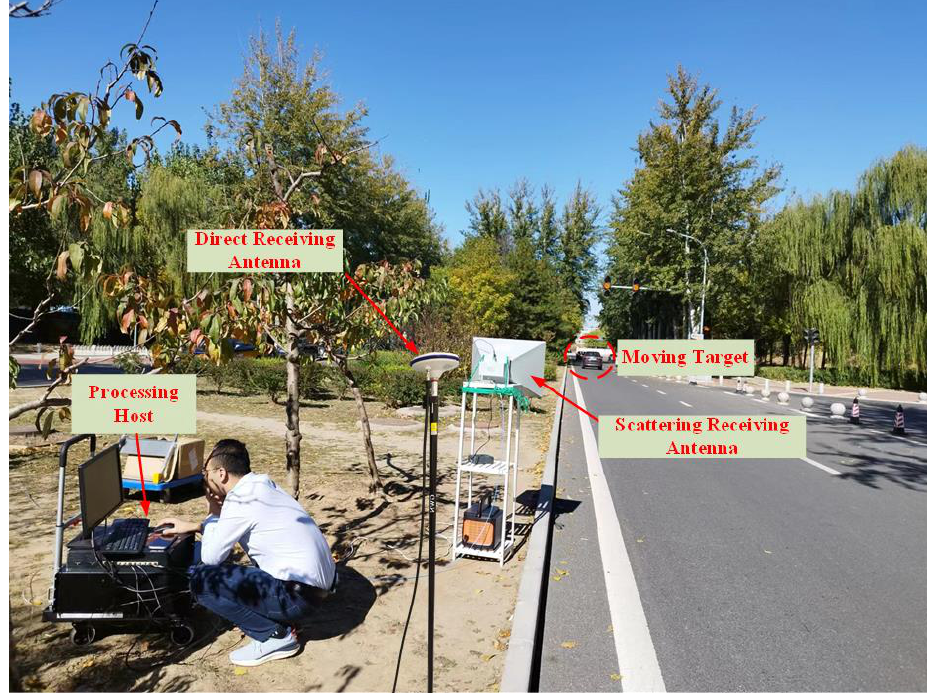
Figure 13. Experimental site scene.